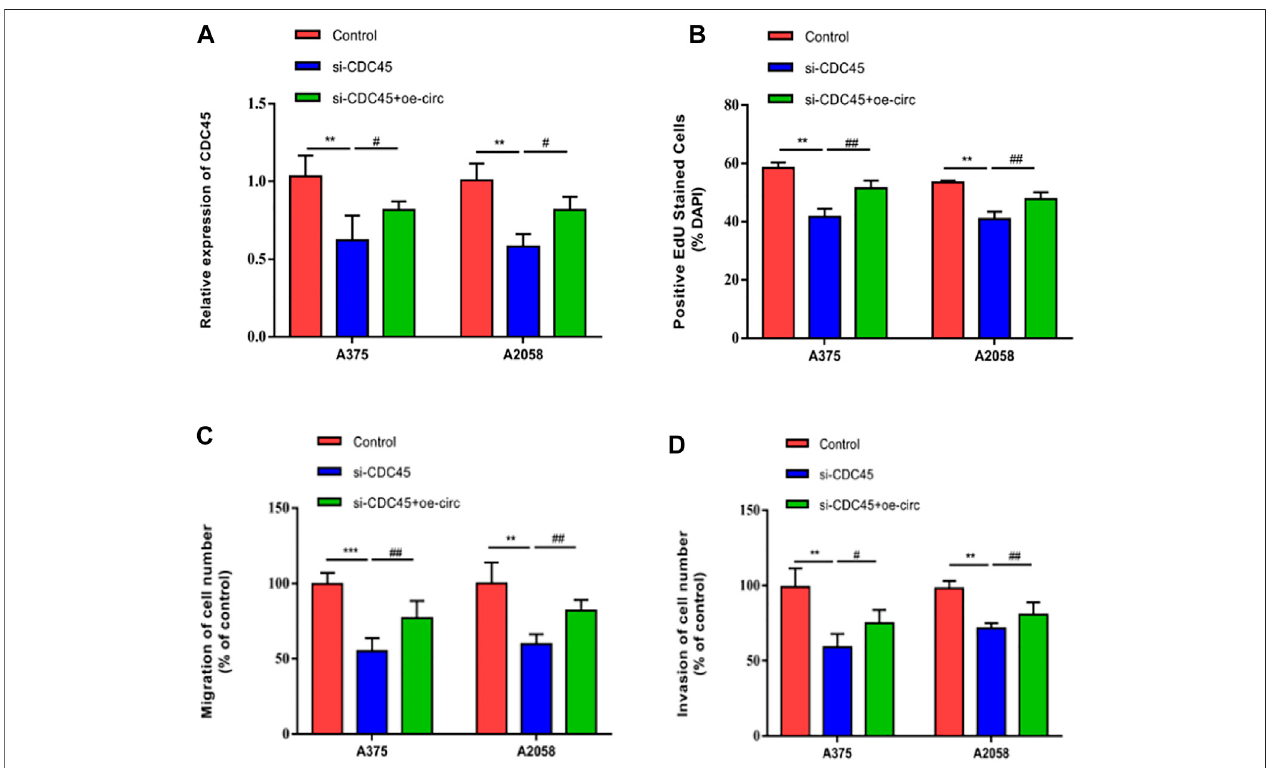
FIGURE5| hsa_circ_0062270 stimulated themalignantprocess ofmelanomabystabilizingCDC45. (A) Co-transfectionofsi-CDC34 andoverexpressedplasmid of hsa_circ_0062270; (B) EdU-positive rate co-regulated by hsa_circ_0062270 and CDC45; (C) Migrative ability regulated by hsa_circ_0062270 and CDC45; (D) Invasion in A375 and A2058 cells co-regulated by hsa_circ_0062270 and CDC45. ** p < 0.01; *** p < 0.001; # p < 0.05; ## p <